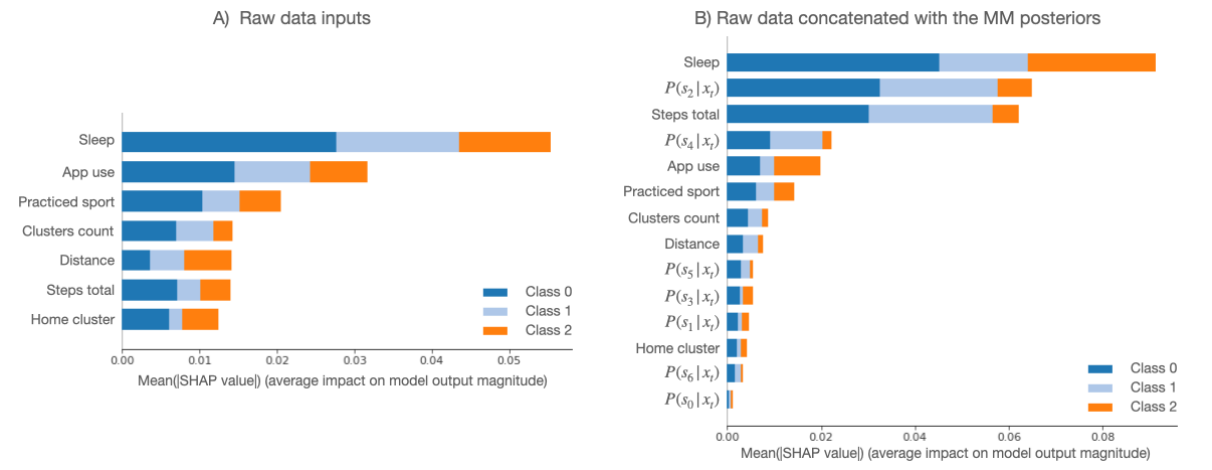
Figure 4. Summary plot of feature importance for the multilayer perceptron models for emotional valence prediction, showing raw data and raw data concatenated with mixture model posteriors. In terms of features, "steps total" refers to step count, "distance" refers to the distance traveled, "sleep" refers to the hours of sleep, "app use" refers to the hours spent using different apps, "home cluster" refers to the time spent at home, "clusters count" refers to the number of visited locations, "practiced sport" is an indicator of whether the patient practiced any sports, and " P ( s i | x t )" refers to the posterior probability in component i . The following class labels were used: 0=negative; 1=neutral; and 2=positive emotional valence. MM: mixture model; SHAP: Shapley additive